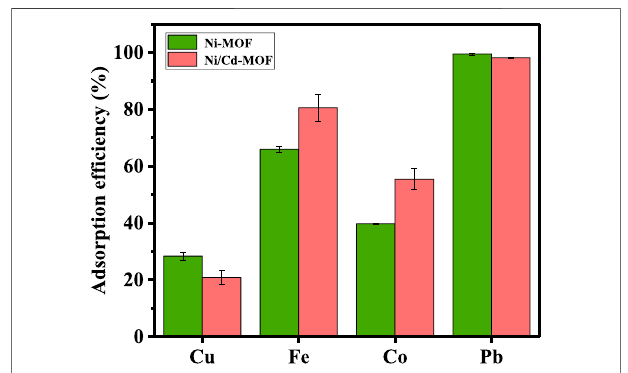
FIGURE 8| The adsorption ofvarious heavy metals ions by Ni-MOF and Ni/Cd-MOF.